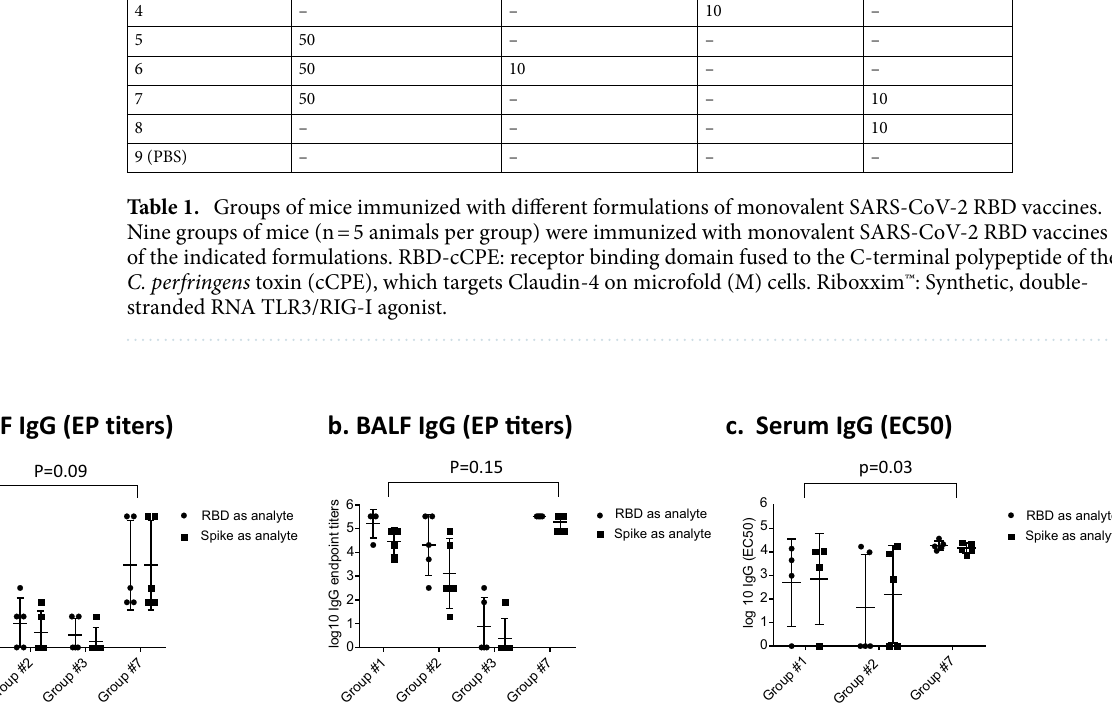
Figure 1. Monovalent SARS-CoV-2 RBD vaccines induce IgG antibody responses in NALF, BALF and serum. Mice were prime-boost immunized (d0, d21) intranasally with non-targeted (nt) RBD, strain Wuhan-Hu-1 (group #1) or primed subcutaneously and boosted intranasally with nt RBD (group #2), or prime-boosted intranasally with nt RBD, adjuvanted with Riboxxim and Chitosan (group #3), or prime-boosted intranasally with M-cell targeted RBD (RBD-cCPE, group #7). All vaccines were adjuvanted with Riboxxim. Sera, nasal fluid (NALF) and bronchioalveolar fluid (BALF) were obtained on day 28, 1 week after the boost, diluted in fourfold steps, and assayed for IgA antibodies in a Luminex assay with recombinant nt RBD, or recombinant trimeric spike protein, both derived from SARS-CoV-2 strain Wuhan-Hu-1. Endpoint titers (EP) were defined as highest sample dilution exceeding the signal of mean of control group (#9) + 3xSD. Log10 EC 50 values were calculated using GraphPad Prism 7, 5PL. For mice with low titers, EC 50 could not be determined and log10 EC 50 (IgG) was accepted as zero. Log10 of endpoint titers or EC 50 were plotted with geometric mean ± geometric SD. Two-way comparisons using the Mann–Whitney U